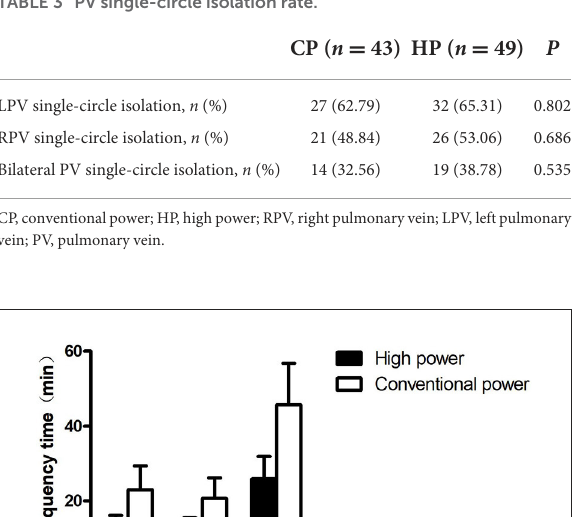
TABLE 3 PV single-circle isolation rate.